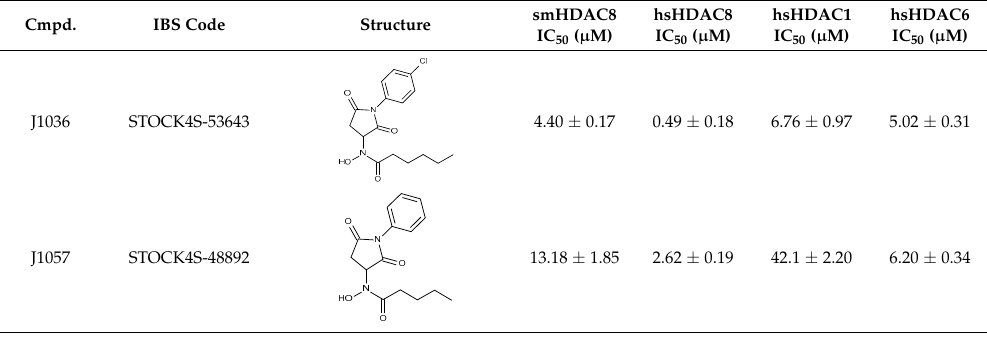
Table1. In vitro inhibition of N -(2,5-dioxopyrrolidin-3-yl)- n -alkylhydroxamate against smHDAC8 and hsHDACs. SAHA and TH65 [35] were included as positive controls. Cmpd.